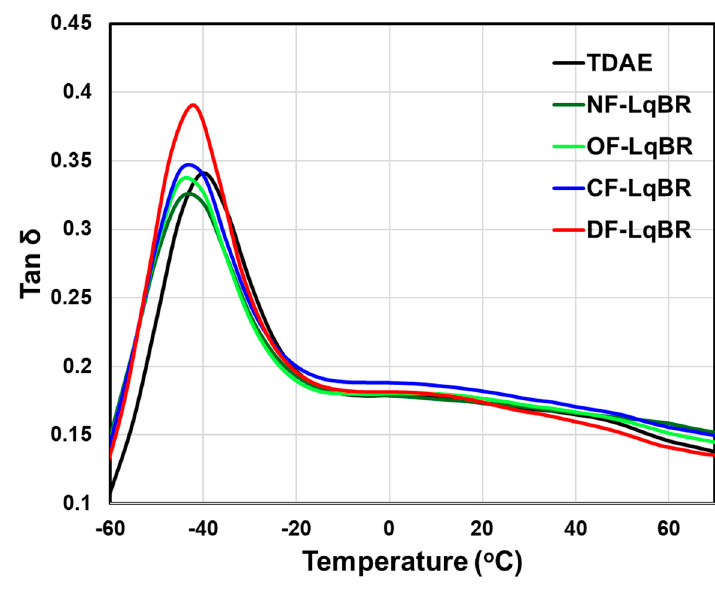
Figure 9. Tan δ curves of the vulcanizates according to the applied processing aids.